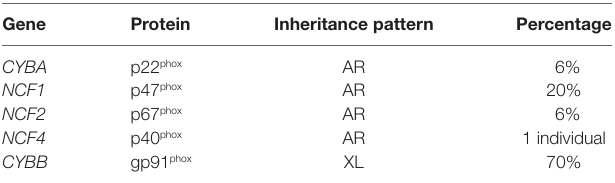
TABLe 2 | Molecular defects of the NADPH oxidase causing CGD